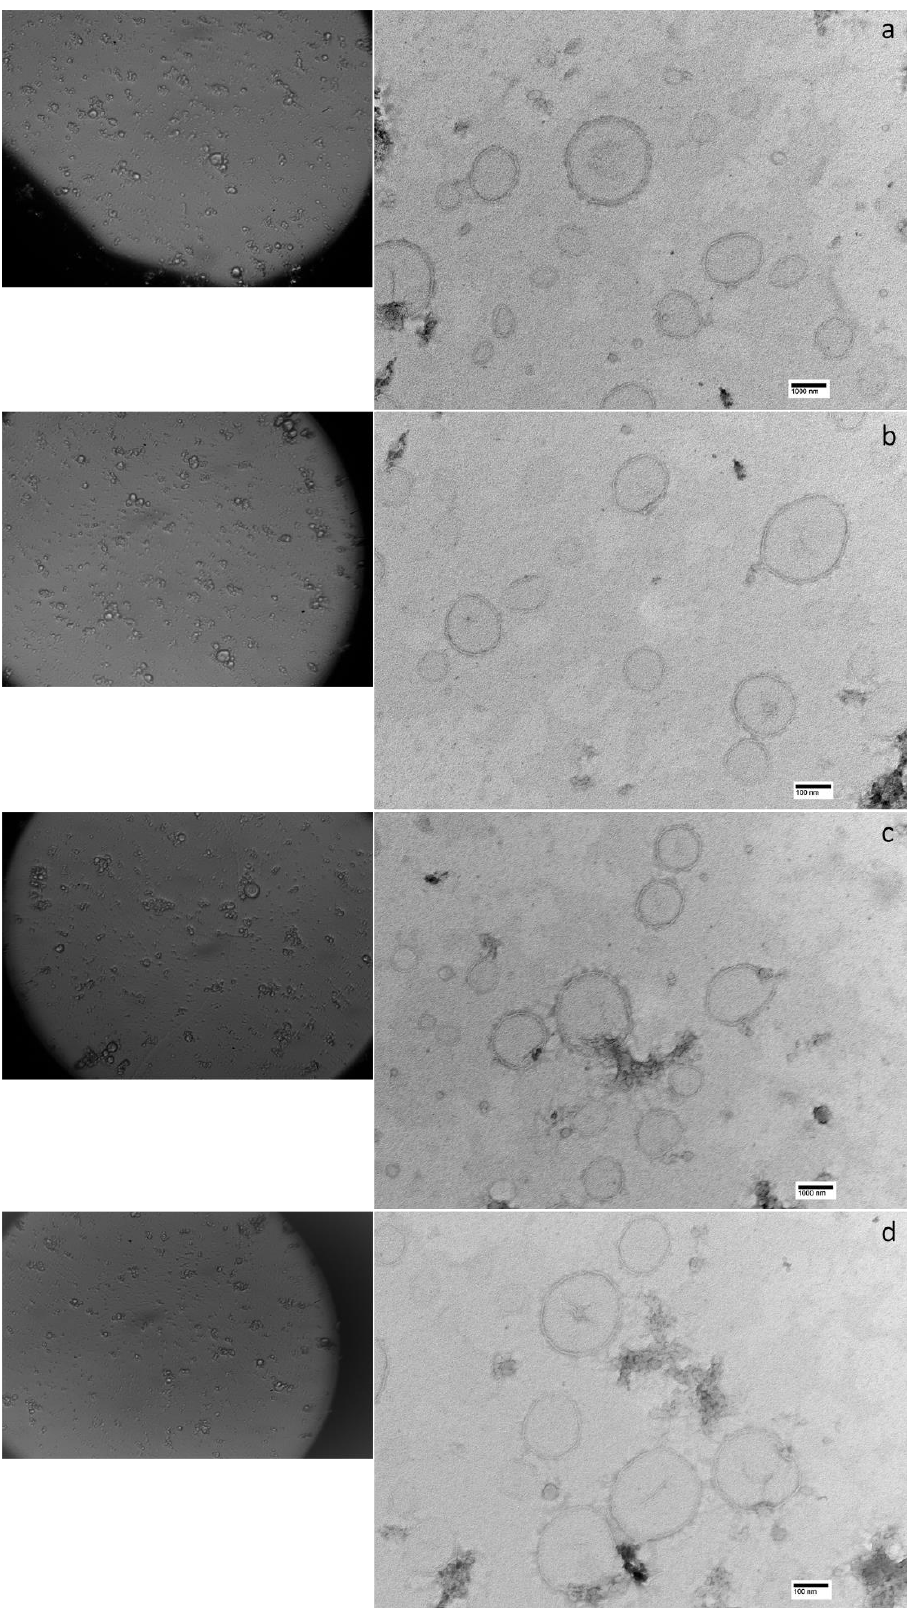
Figure 4. Photomicrographs of the liposomal dispersions by optical (on left) and TE microscopy (on right): ( a ) F7.4-u; ( b ) F7.4-e; ( c ) F5.5-u; ( d ) F5.5-e.